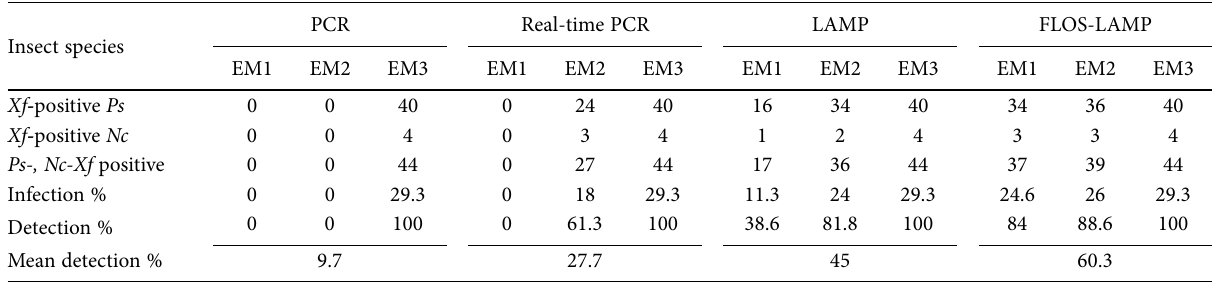
Table 2. Comparative analyses between PCR, real-time PCR, LAMP and FLOS-LAMP assays, applied on TNAs extracted by three different methods (EM1, EM2 and EM3) from 100 Philaenus spumarius ( Ps ) and 50 Neophilaenus campestris (Nc ) specimens, for detection of Xylella fastidiosa ( Xf